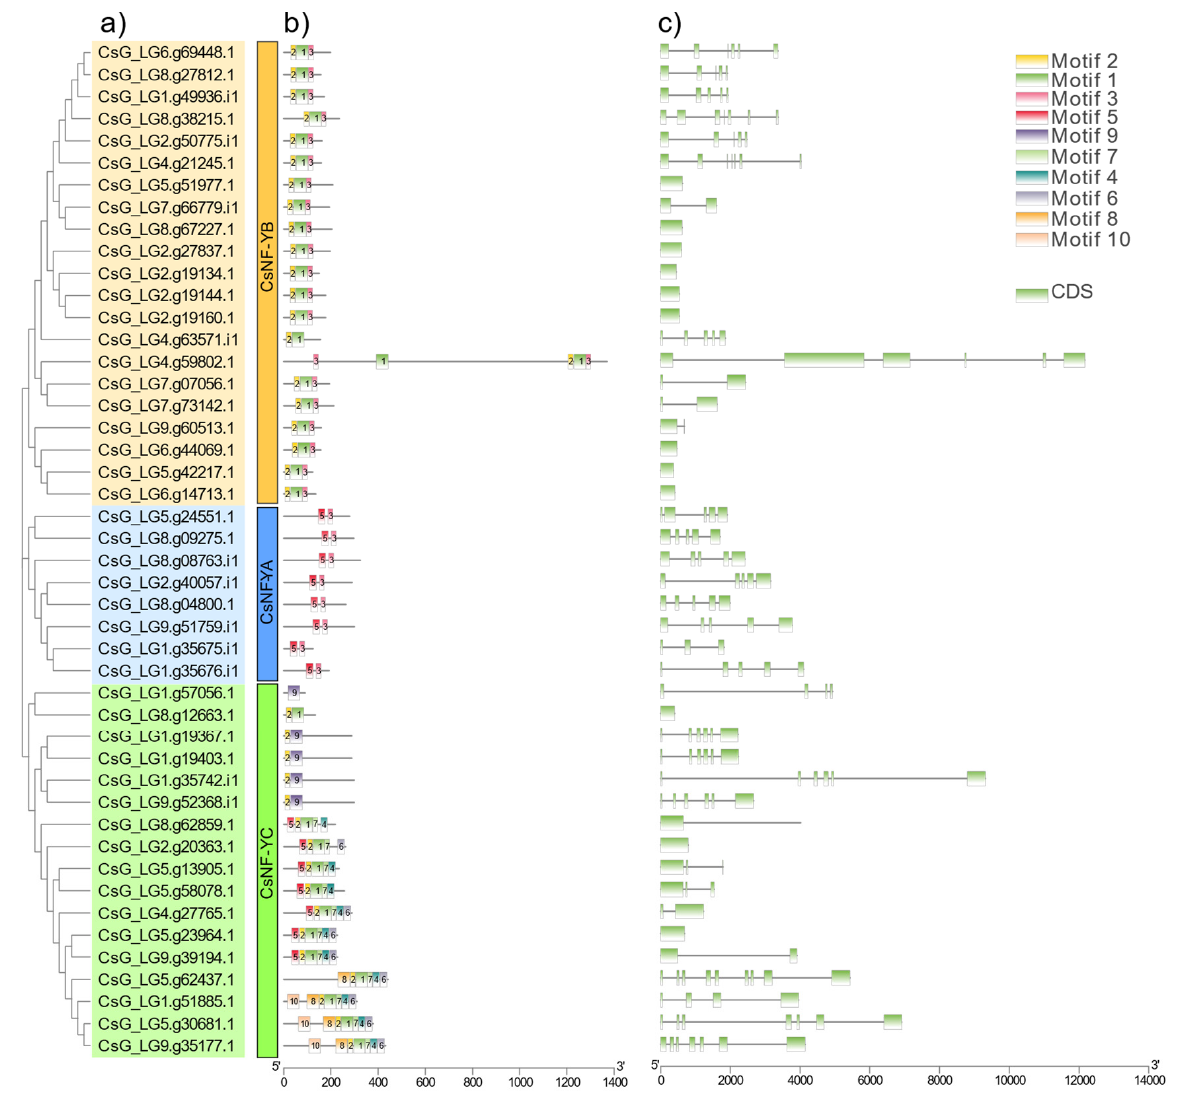
Figure 3. Motif structure, conserved domains and gene structure of CsNF-Y family were analyzed using MEME, NCBI and TBtools. ( a ) CsNF-Y gene was constructed using MEGA-X to build an unrooted phylogenetic tree. ( b ) Schematic diagram of motif structure in the CsNF-Y gene family using MEME. Different colors and numbers represent ten different motifs. ( c ) CsNF-Y gene structure analysis, including intron and exon distribution.